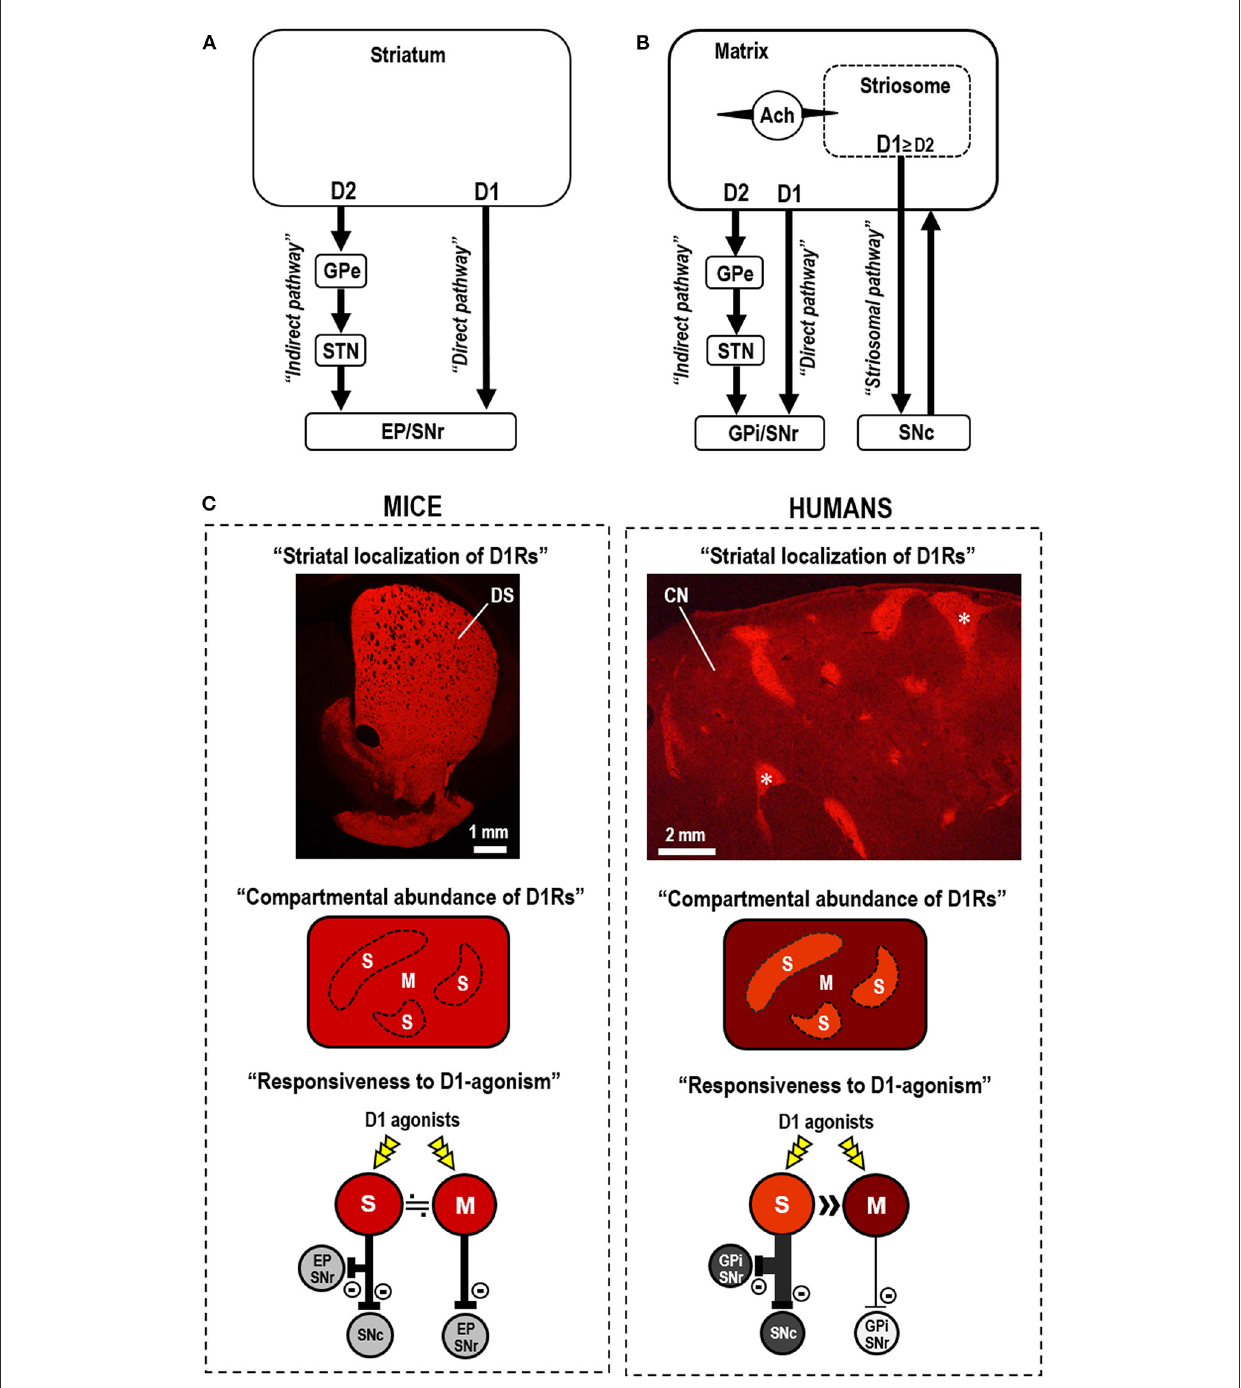
FIGURE1 Striatal dopamine D 1 systems in the functional anatomy of the basal ganglia. (A) Direct-indirect pathway model of the basal ganglia circuit (Alexander et al., 1986; Albin et al., 1989). The direct-indirect pathway model suggests that striatal dopamine D 1 receptor (D 1 R)-expressing medium spiny neurons (MSNs) primarily form the direct pathway that targets the globus pallidus internus (GPi)/entopeduncular nucleus (EP) and substantia nigra pars reticulata (SNr). D 2 R-expressing MSNs form the indirect pathway that targets the globus pallidus externa (GPe), which sends projections to the subthalamic nucleus (STN). (B) In the three-pathway model of striatal efferent connectivity (Graybiel et al., 2000; Crittenden and Graybiel, 2011), striosomal MSNs form the striosome-specific pathway (striosomal pathway) that targets the substantia nigra pars compacta (SNc), which projects back to the entire striatum. Most MSNs that form the direct and indirect pathways lie in the matrix compartment. Striosomal MSNs also communicate with adjacent matrix MSNs via cholinergic interneurons (marked by Ach). The collaterals of the striosomal projections in GPi/EP and GPe are not shown in this diagram. (C) Compartmental differences in the abundance of D 1 Rs and responsiveness to D 1 R activation in mice (left) and humans (right). In mice, D 1 Rs are abundant in both the striosome (S) and matrix (M) compartments in the dorsal striatum (DS), with no apparent compartmental difference in abundance. This is evident in the immunofluorescence image of a mouse striatal section stained for D 1 Rs (Morigaki et al., 2017). Thus, no difference in the response to D 1 R-selective agonists (D 1 -agonists) is apparent between the striosome and matrix compartments in the mouse striatum. In humans, a marked compartmental difference exists in the abundance of D 1 Rs in the neostriatum. This is